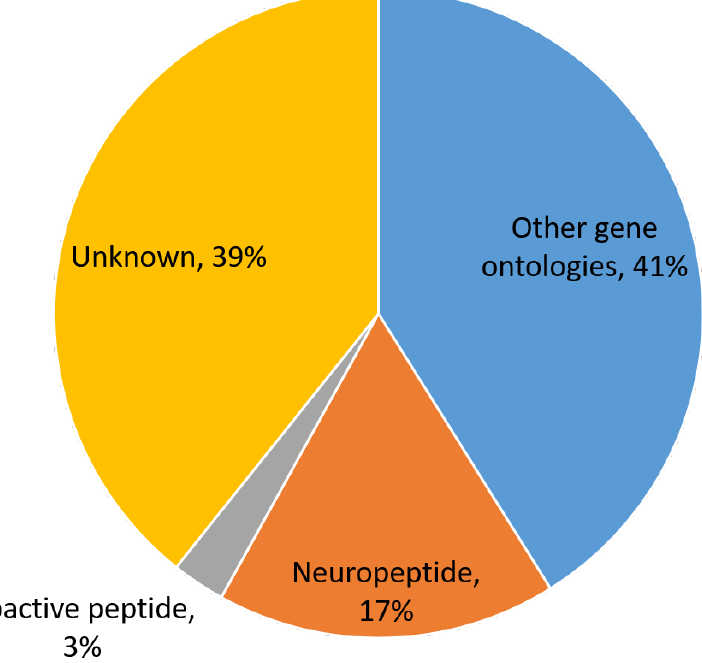
Figure 2. Classification of S. mekongi peptidome identified by mining approach.